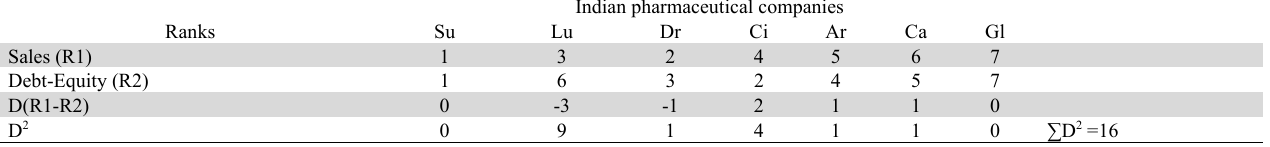
Originating Source: R1 and R2 from table 1 and 4.